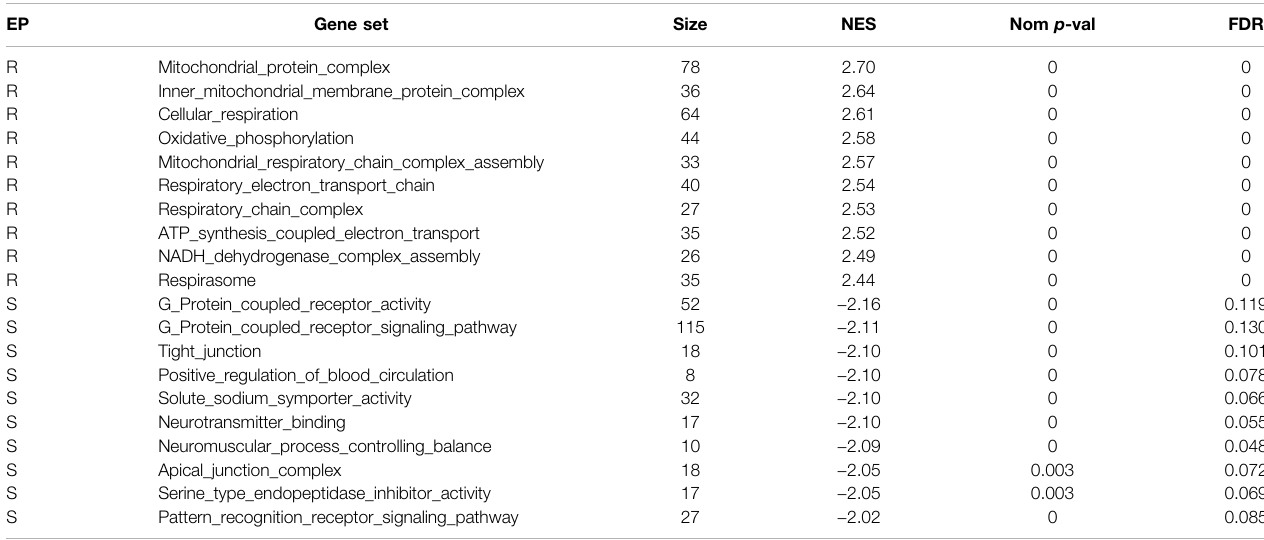
TABLE 6 | GSEA of GO gene